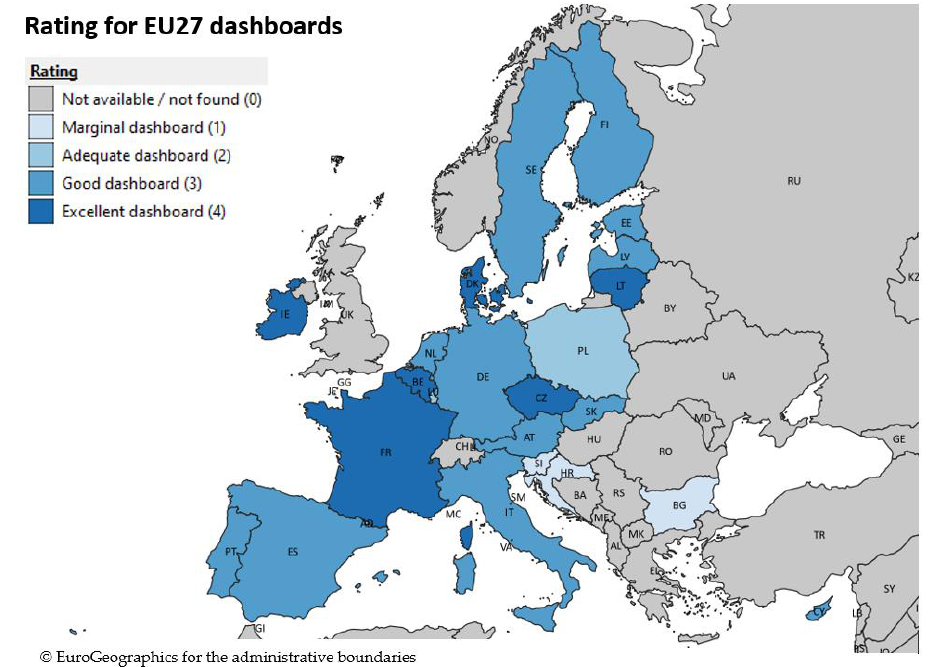
Figure 2. Rating of the evaluated dashboards from EU Member States.